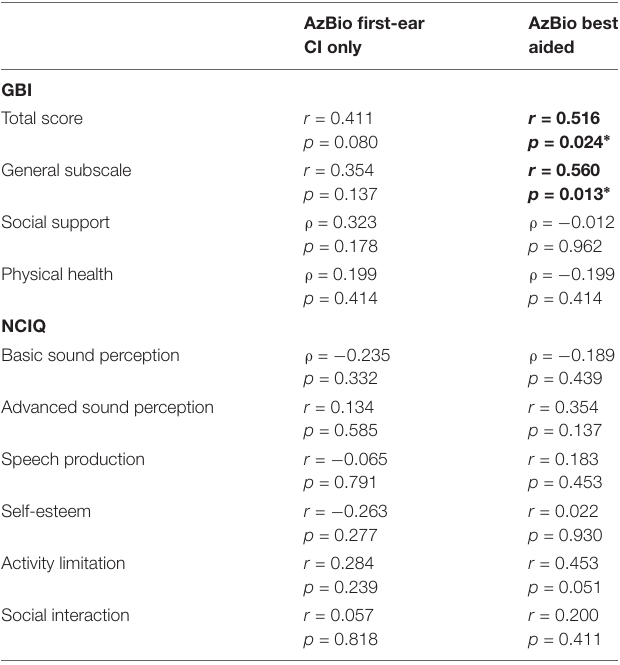
TABLE 5 | Correlations between AzBio speech scores (controlled for age), GBI, and NCIQ questionnaires.